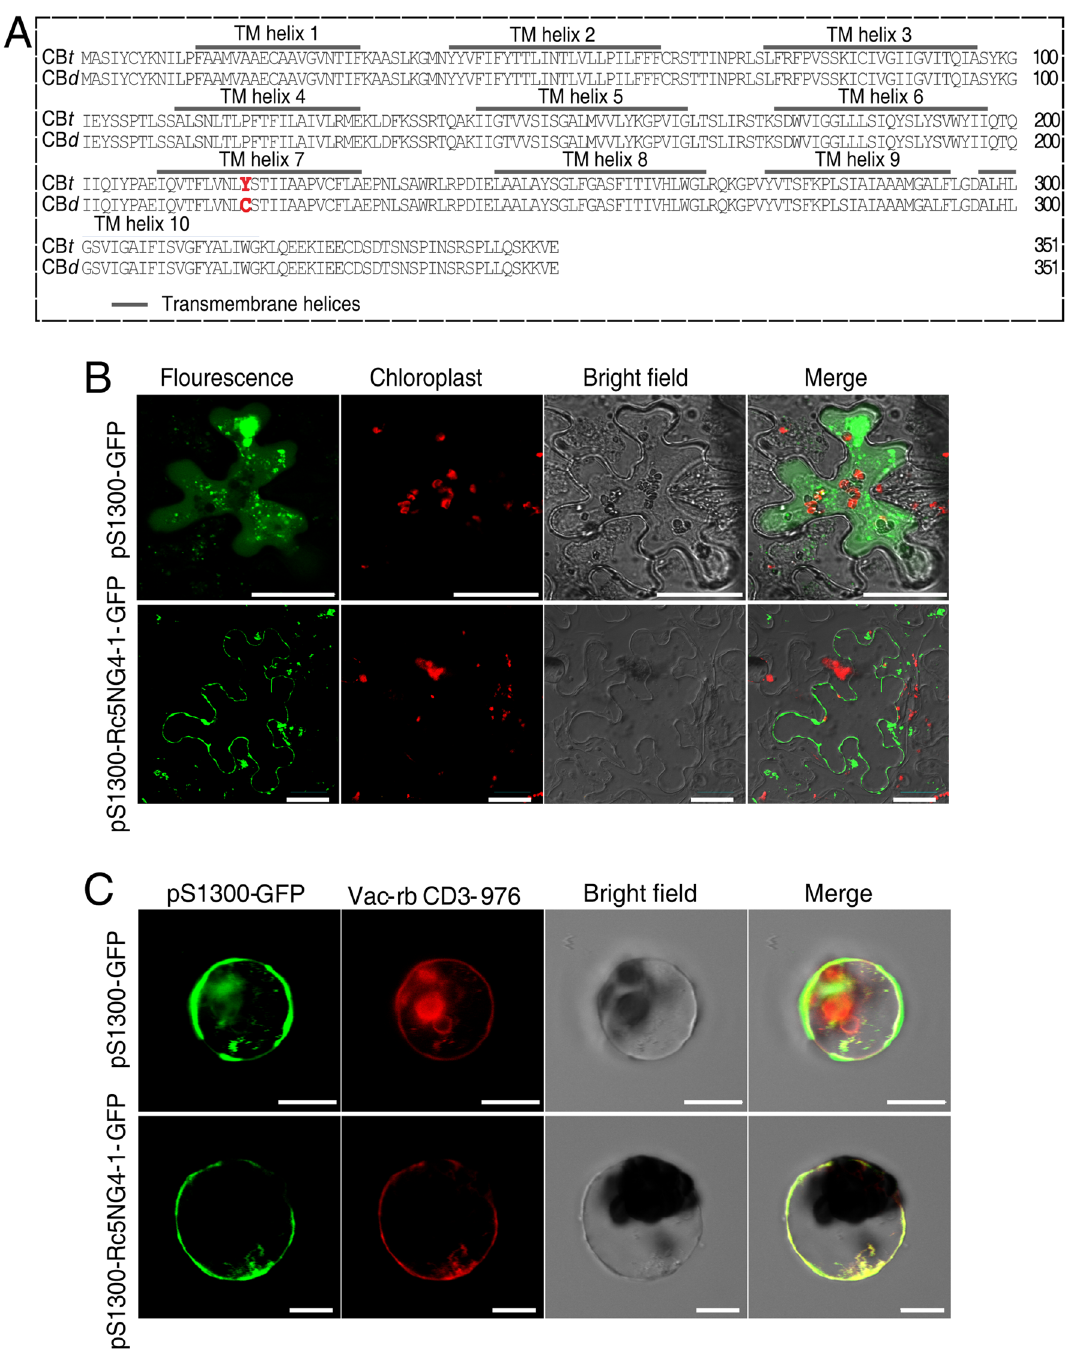
Figure 5. Protein structure and subcellular localization of Rc5NG4-1. ( A ) Protein sequence structures and transmembrane (TM) domains of Rc5NG4-1 in CB t and CB d predicted using TMHMM. The 218th amino acid change are marked red, which induced by the non-synonymous SNP located in 1133 bp position of Rc5NG4- 1 . ( B ) Rc5NG4-1 -fused GFP was expressed in hypoepidermal cell of tobacco leaves. Scale bar = 30 μm. ( C ) Rc5NG4-1 -fused GFP was transiently co-expressed with the vacuolar membrane marker in protoplasts. Empty vector pS1300-GFP was expressed in protoplasts as a control (top panels). Vac-rb CD3-976, the vector carries tonoplast marker γ-TIP coding sequence (aquaporin with tonoplast localization). Images in bottom panels show colocalization of Rc5NG4-1 and γ-TIP. The fluorescence graphs were detected by confocal microscope in ( B ) and ( C ). Scale bar = 10